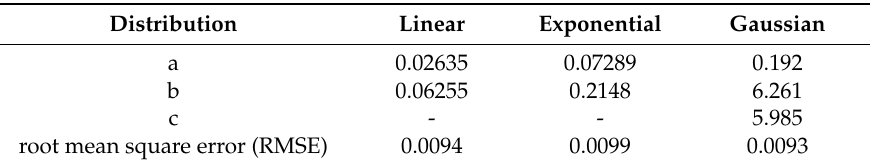
Table 2. Estimated parameters of distribution.